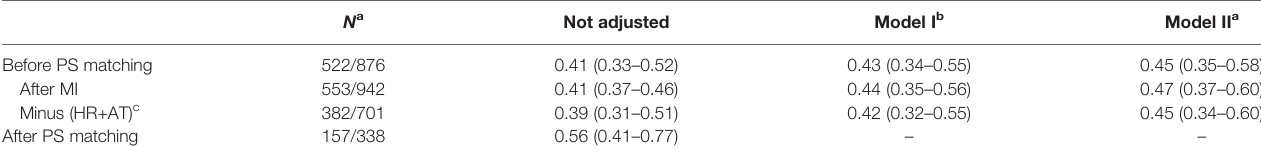
TABLE 3 | Hepatic resection [ vs. transarterial chemoembolization (TACE)] and multivariate hazard ratios of overall survival with 95% CIs in Barcelona Clinic Liver Cancer (BCLC) stage B hepatocellular carcinoma